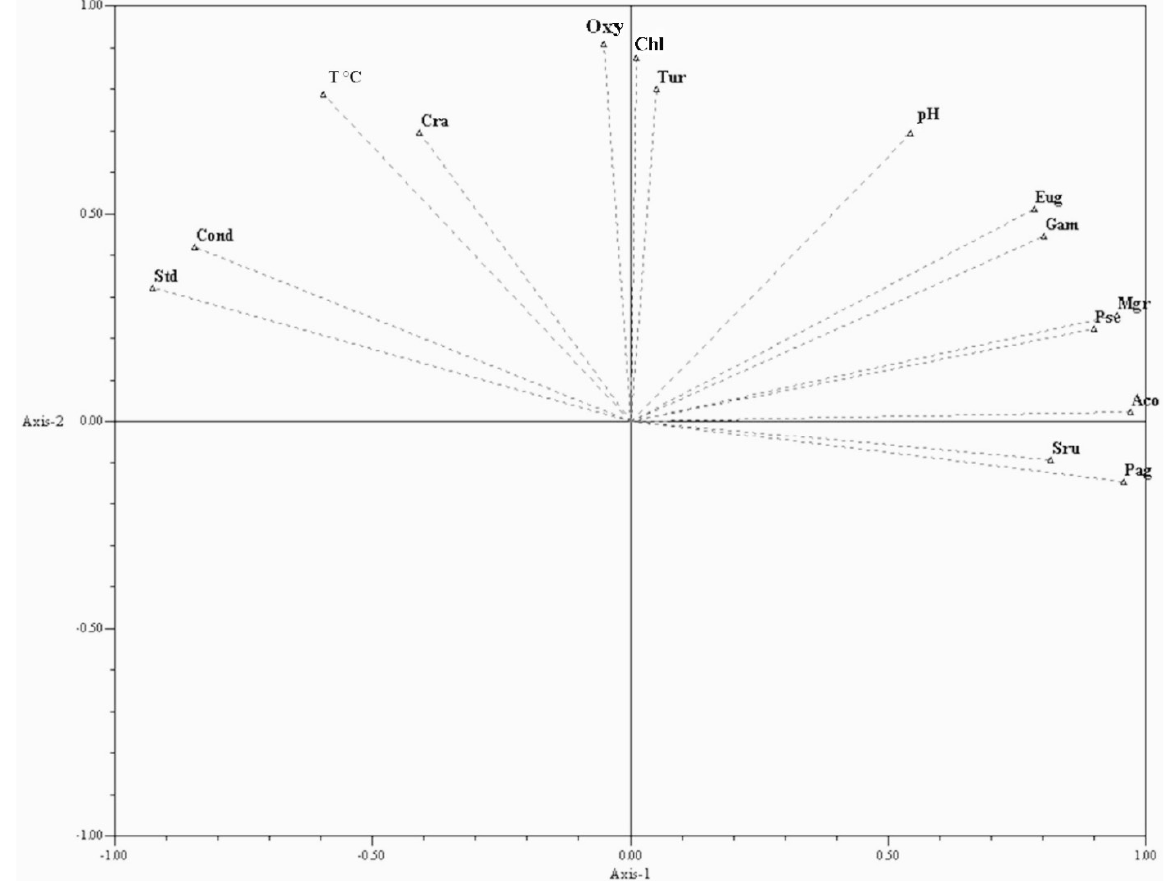
Fig. 4 – PCA of the most representative environmental and biological variables in the Carpina reservoir (PE, Brazil) from January to November 2006. Abbreviations: Aco ( Anabaena constricta ), Cra ( Cylindrospermopsis raciborskii ), Gam ( Geitlerinema amphibium ), Pag ( Planktothrix agardhii ), Pse ( Pseudanabaena sp.), Sru ( Synedra rumpens ), Mgr ( Monoraphidium griffithii ), Eug ( Euglena sp.), Chl- a (Chlorophyll a ), T ◦ C (water temperature), Oxy (dissolved oxygen), Cond (electrical conductivity), TDS (total dissolved solids), Tur (turbidity) and